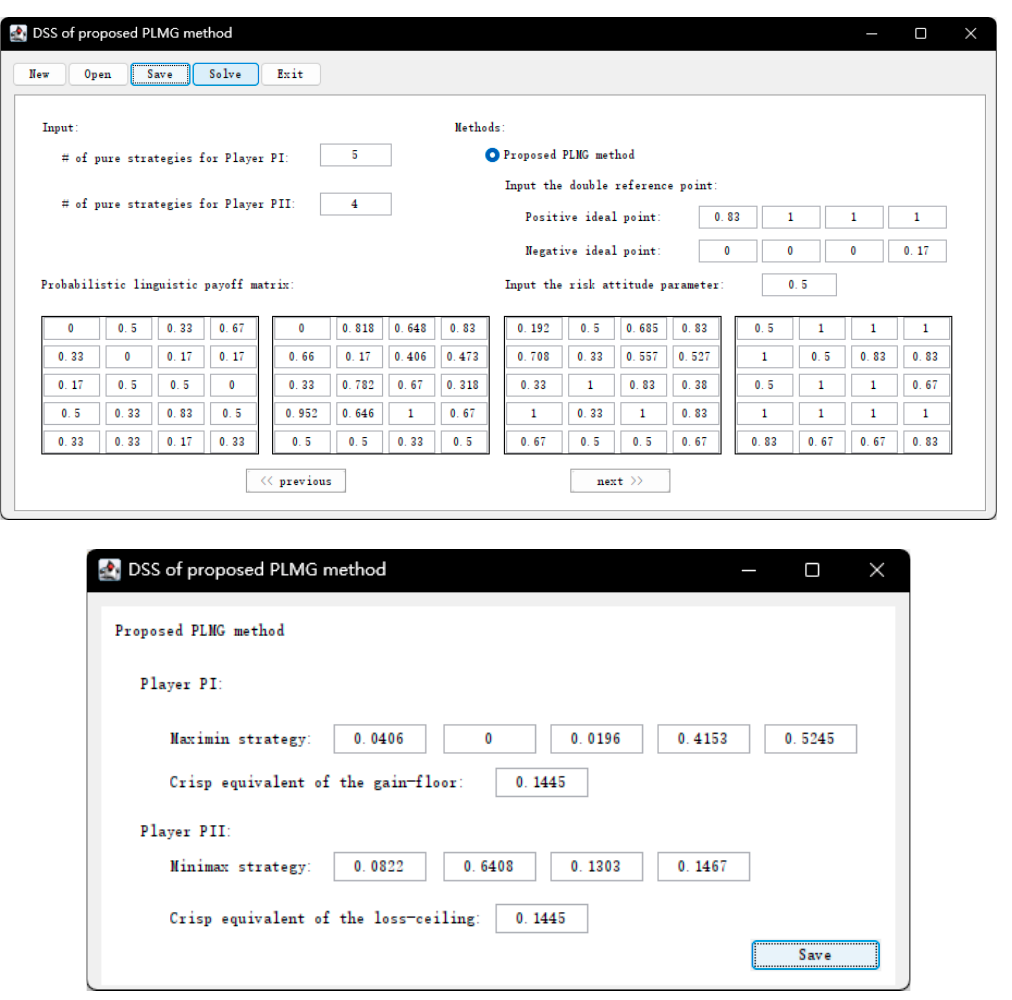
Figure 15. Main interfaces of results obtained by the proposed